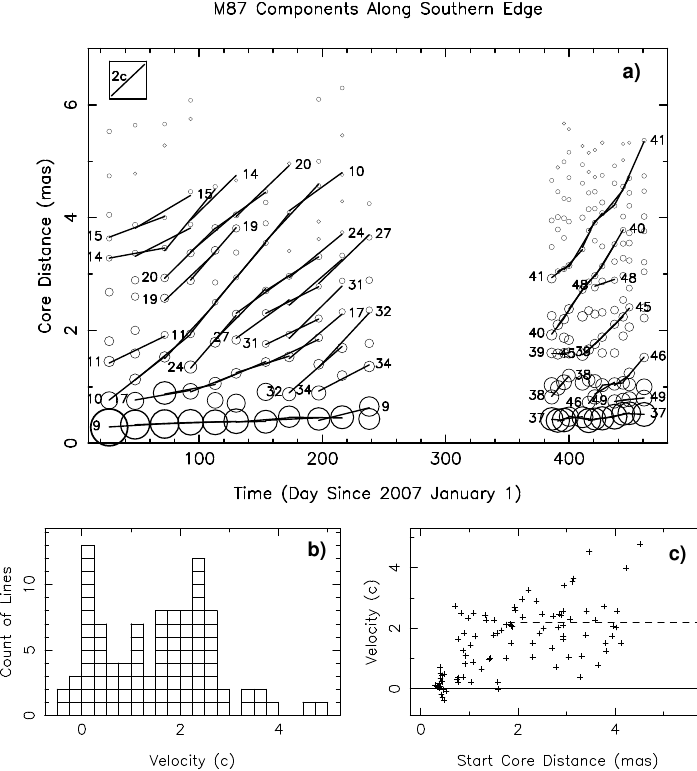
Figure 4. The data, based on visual determination of component positions and of associations of components between epochs, that was used to characterize the component speeds along the southern edge of the jet. Similar data for the northern edge will be given in reference [17]. ( a ) The symbols show the positions of the peaks such as those shown in Figure 3 with the symbol sizes (areas) proportional to peak flux density. The numbers indicate components that were visually identified to correspond from epoch to epoch. The lines represent fits for position and speed for groups of three peaks for the presumed same feature from adjoining epochs; ( b ) A histogram of speeds from the three-peak fits;